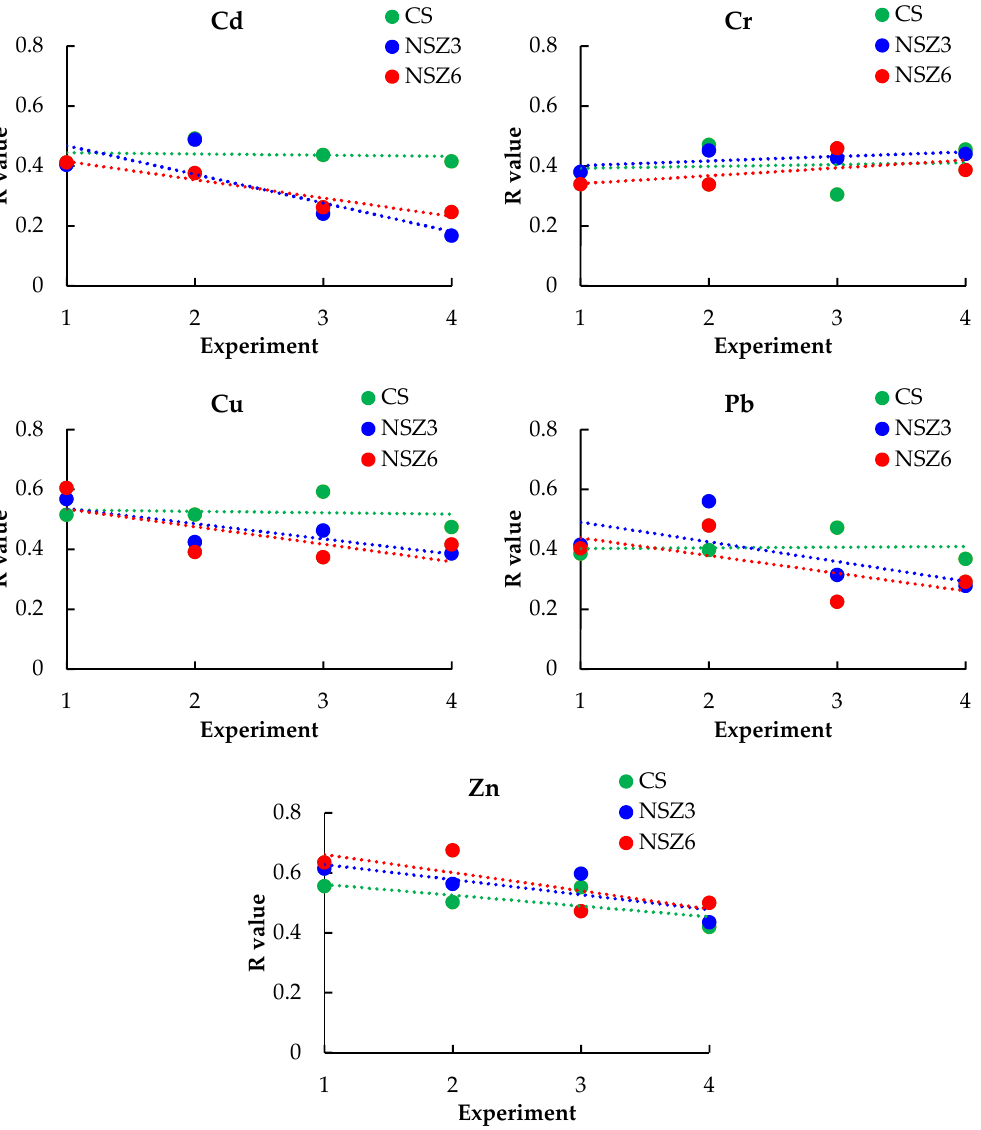
Figure 2. Ratio of C DGT to C sol (R value) in the control soil (CS) and soil amended with 3% (NZS3) and 6% (NZS6) zeolite at 0, 1, 2 and 3 months after amendment (experiments 1, 2, 3, 4).